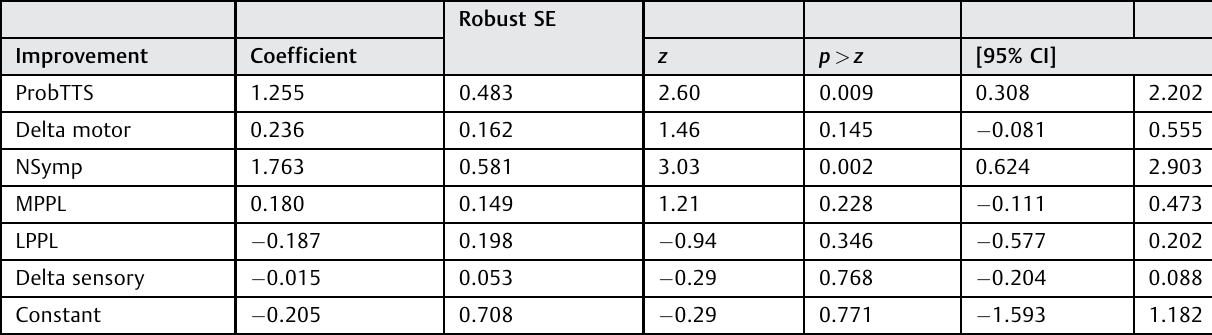
Table 5 Improvement outcome regression modeling group rating (ProbTTS), nerve symptoms, and nerve conduction study data